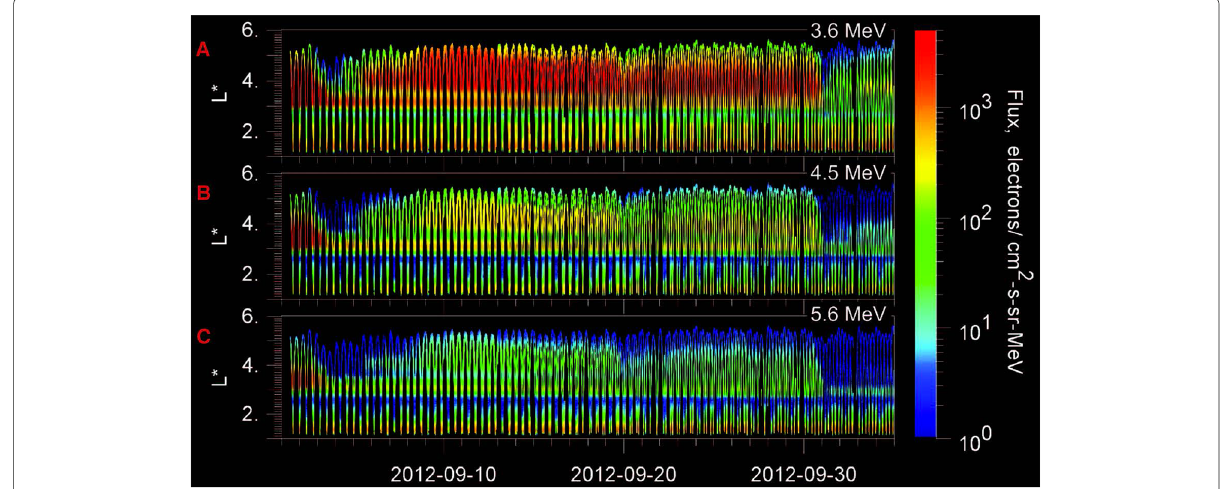
Fig. 3 Formation of the third belt or “storage ring” soon after the passage of a CME effectively “splitting” the outer belt observed by the REPT instrument on Van Allen Probes; reproduced from Baker et al.